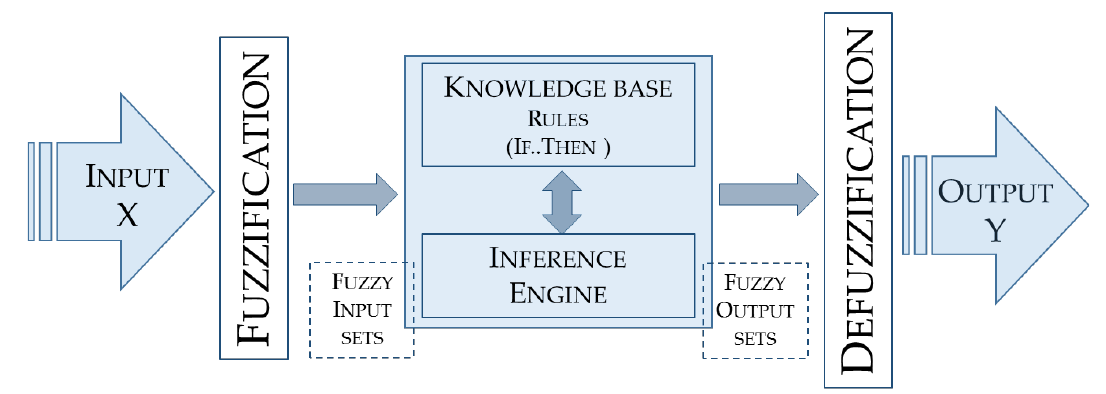
Figure 1. Structure identification of fuzzy model.